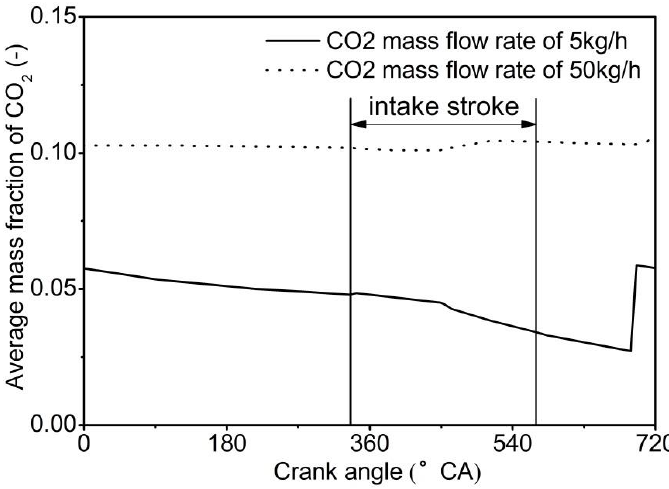
Figure 9. Average CO 2 mass fraction at the outlet of intake port 2 of cylinder 1 versus the crank angle with different mass flow rates of CO 2 .